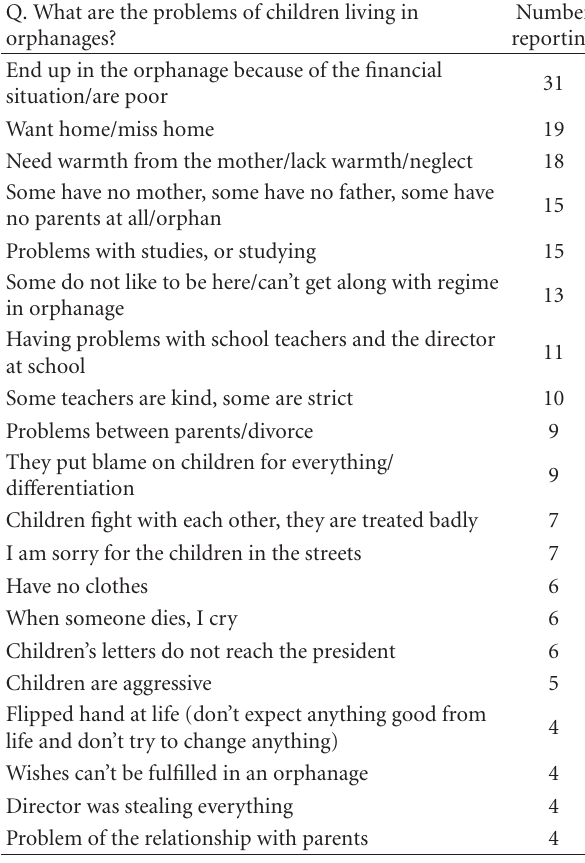
Table 5: Study 2 free list responses, problems of children in orpha- nages, all orphanages ( N = 38).